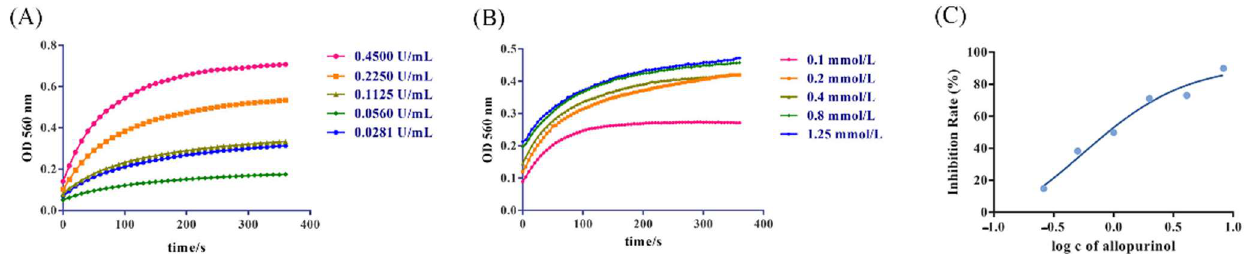
Figure 1. Optimization of XOD catalytic reaction conditions. ( A ) Kinetics of XOD at enzyme concentrations. ( B ) Kinetics of XOD at substrate concentrations. ( C ) Inhibition rate of allopurinol.